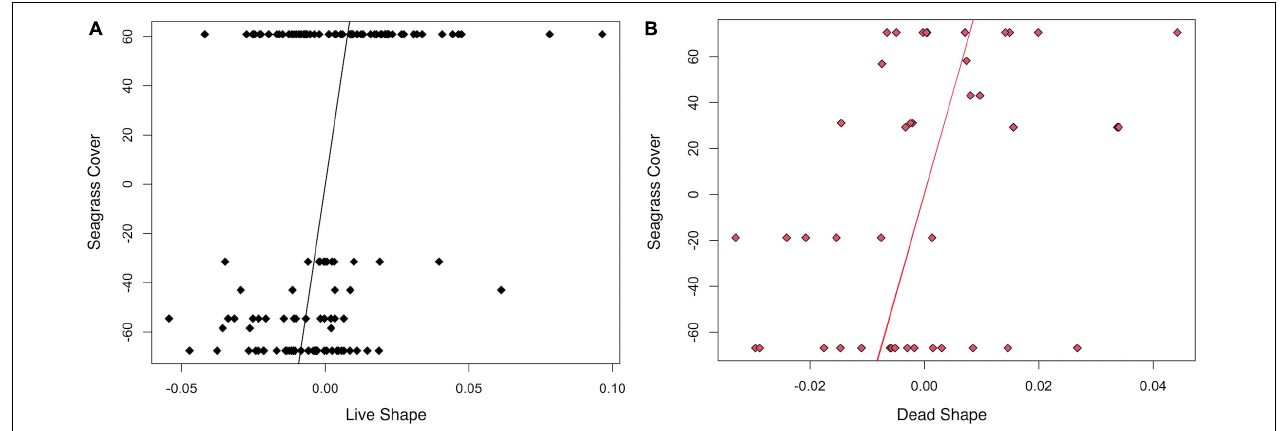
FIGURE 4 | Two-block partial least squares analyses of Procrustes shape ( x -axis) by seagrass composition and cover at the time of collection ( y -axis) for specimens collected in transects 6 and 7. (A) Live specimens (r-PLS: 0.341, p = 0.028, effect size: 2.1957), with each row representing, from top to bottom, 100% Halodule wrightii , 20% H. wrightii /80% bare sand, 10% H. wrightii /90% bare sand, 100% bare sand, 30% Syringodium filiforme /70% bare sand, and 100% S. filiforme . (B) Dead specimens (r-PLS: 0.383, p = 0.483, effect size: –0.0285), with each row representing, from top to bottom, 100% bare sand, 30% S. filiforme /70% bare